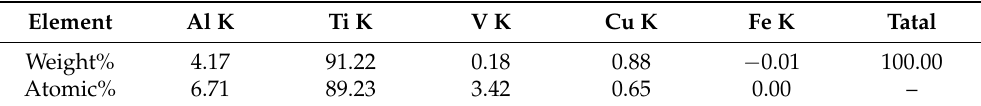
Table 5. Composition of Titanium alloy workpiece.